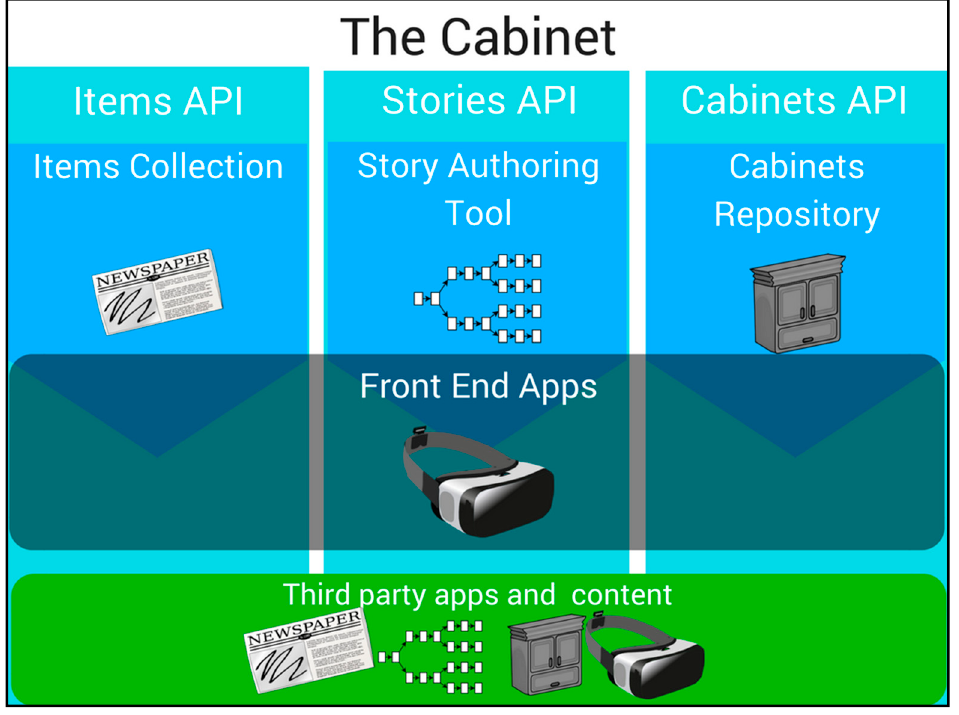
Figure 11. Technical architecture.